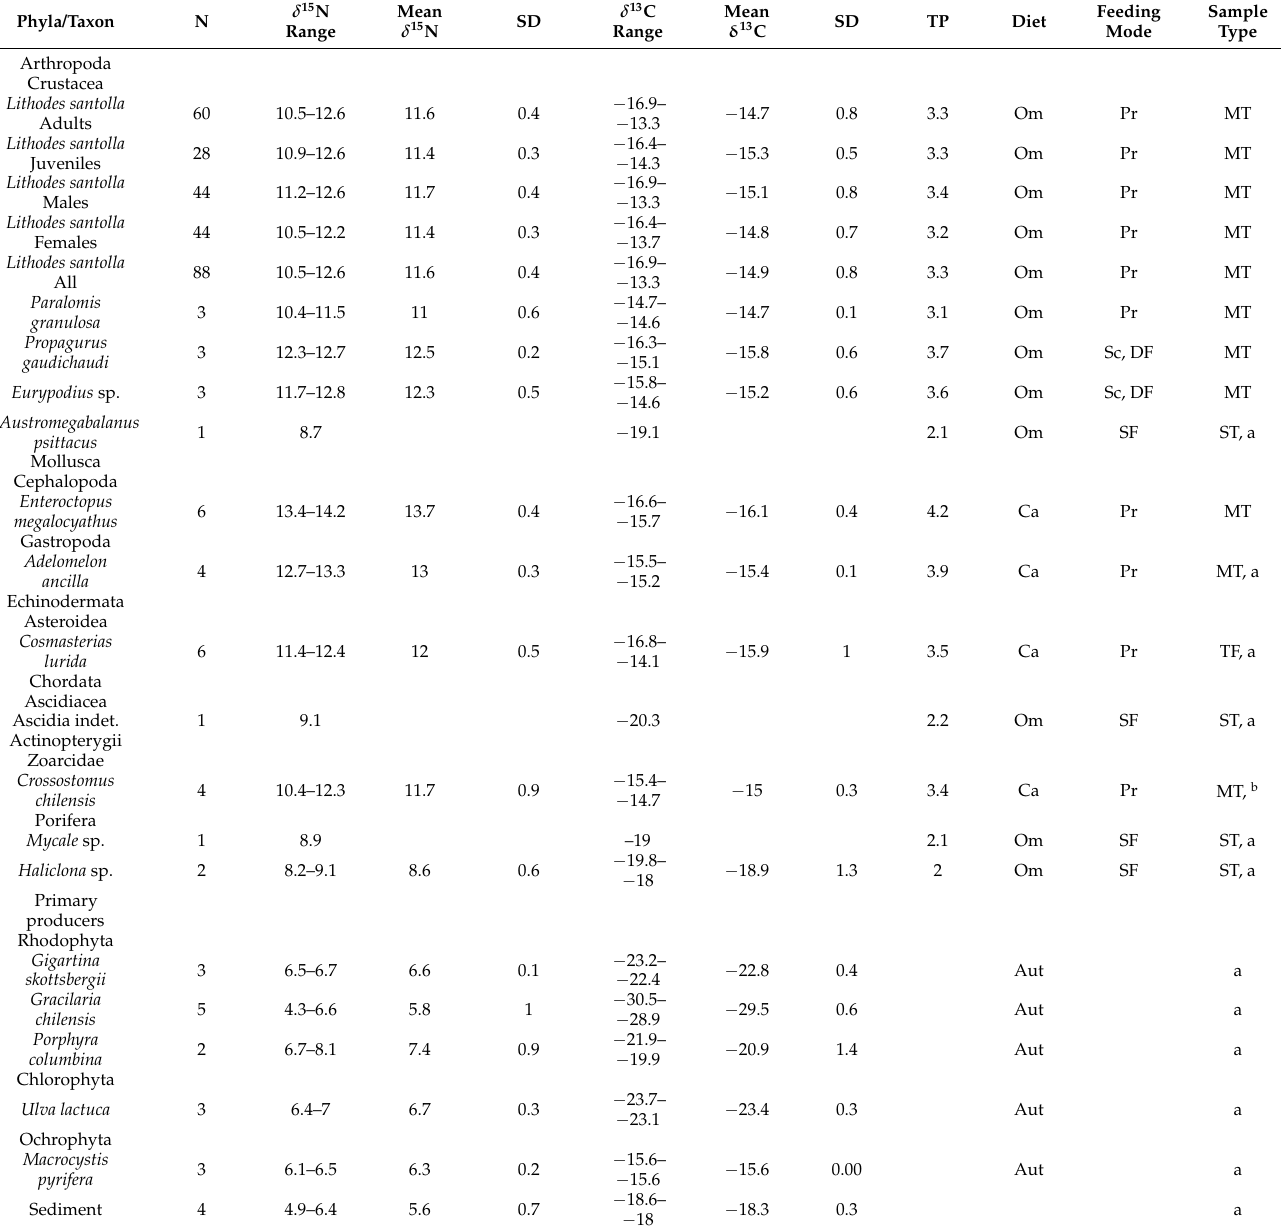
Table 6. Summary statistics of the isotopic composition of δ 13 C and δ 15 N values (range, mean, and standard deviation), sample size, trophic position, diet, feeding mode and sample type of Lithodes santolla , associated fauna, primary producers, and sediment collected in Nassau Bay, Cape